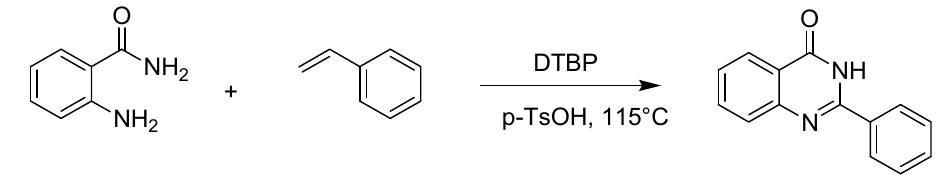
using Di-tertiary-butyl peroxide (DTBP) and p-Toluene sulfonic acid (p-TsOH) to get